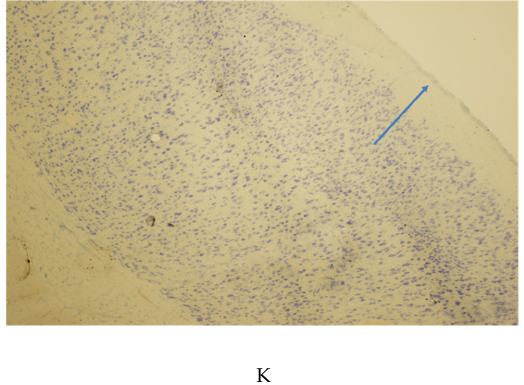
Figure 1. ( A ) HIV-1 transgenic rat (HIV-1TGR) coronal section of cortex stained with hematoxylin and eosin. This image of the 10-micron thick section was taken at 4×. In the present section, the surface of the brain is to the right (blue arrow), and the box encloses the cortical areas where both normal neurons (Arrow 3) and degenerating neurons (Arrow 4) could be found. Number 2 and the blue line it is pointing to is a white-matter tract beneath the cortex, and the area surrounding Number 1 is the subcortical gray matter. CXCR4-positive neurons can be found through the cortical area with immunohistochemistry. ( B ) HIV-1TGR coronal section of cortex stained with hematoxylin and eosin. This image of the 75-micron thick section was taken at 40×. H&E sections of the HIV-1 TG rat brains were analyzed for inflammation and other abnormalities. Inflammatory infiltrates were absent. A number of changes were noted, such as the “dead and red” neurons. Such neurons could be found at a very low frequency in the cortex. An arrow points to an example of a “dead and red” neuron. Neural cell death was confirmed with CSS. ( C ) The HIV-1TGR coronal section of the cortex is stained with CSS and counterstained with neutral red. This image of the 75-micron thick section was taken at 4×. In the present section, the surface of the brain is to the right (black Arrow 3), and the box encloses the cortical area where both normal neurons (stained red with no silver impregnation) and degenerating neurons (Arrows 1 and 2) could be found. Arrow 4 and the blue line it is pointing to locates the subcortical white-matter tract. The area surrounding Number 5 is the subcortical gray matter. Small blue arrows point to silver artifact (Arrow 6) precipitation and partial degenerating processes. Non-neural cells, such as microglia, may be labeled. A high-power image of a degenerating neuron (Number 1) can be found in Figure 1D. ( D ) The HIV-1TGR coronal section of the cortex is stained with CSS and counterstained with neutral red. This image of the 75-micron thick section was taken at 40×. This high-power image of the degenerating neuron from Figure 1C demonstrates pyramidal neuronal morphology. Degenerating neurons were often found in isolation. CSS at Arrow 1. Arrow 2 points to a normal fast red-staining cortical neuron. Arrow 3 points to a capillary. ( E ) The HIV-1TGR coronal section of the cortex is stained with CSS and counterstained with neutral red. This image of the 75-micron thick section was taken at 40×. This high-power image of the CSS demonstrates several degenerating neurons in close proximity to each other. The silver degeneration stain reveals that several cortical pyramidal cells are in different states of degeneration. Large arrows identify degenerating neurosomata of cortical pyramidal cells (Numbers 1 and 2). Smaller arrows point to degenerating neural processes (Arrows 3). ( F ) The HIV-1TGR coronal section of the cortex is stained with CSS and counterstained with neutral red. This image of the 75-micron thick section was taken at 60× water immersion. The degenerating neuron is darkly labeled (Arrow 1); its processes (Arrows 2) are granularly labeled, suggesting this neuron has been atypical for some time. Arrow 3 points to a normal neuron stained with neutral red. ( G ) Nontransgenic control rat coronal section of the cortex is stained with CSS and counterstained with neutral red. This image of the 75-micron thick section was taken at 4×. Brains of nontransgenic control rats did not display any observable degenerating neurons. Artifactual silver precipitate could be identified (Arrows 2) throughout the sections. Red blood cells